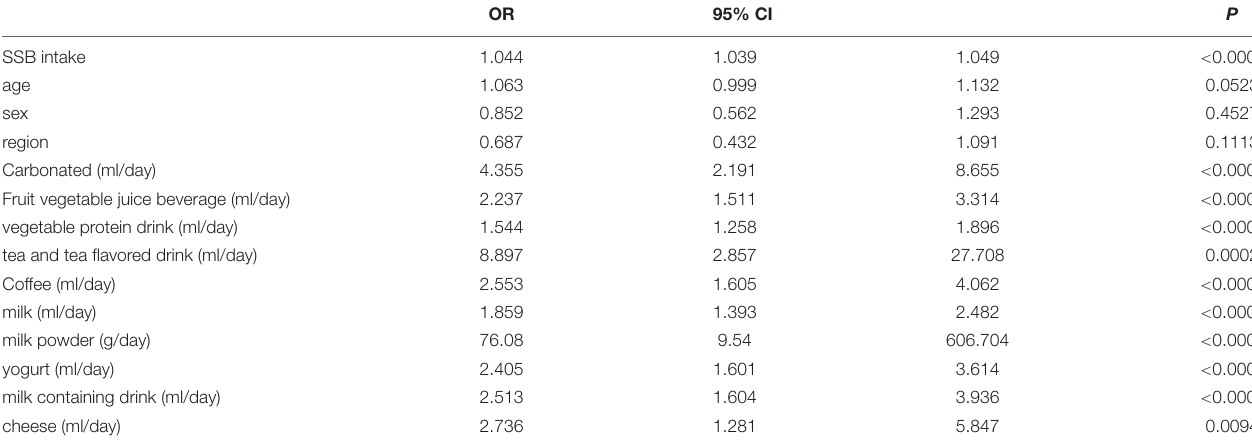
TABLE 5 | Logistic regression analysis of relationship between excessive SSB sugar intake ( ≥ 25 g/day) and consumption of intake of various beverages. OR 95% CI